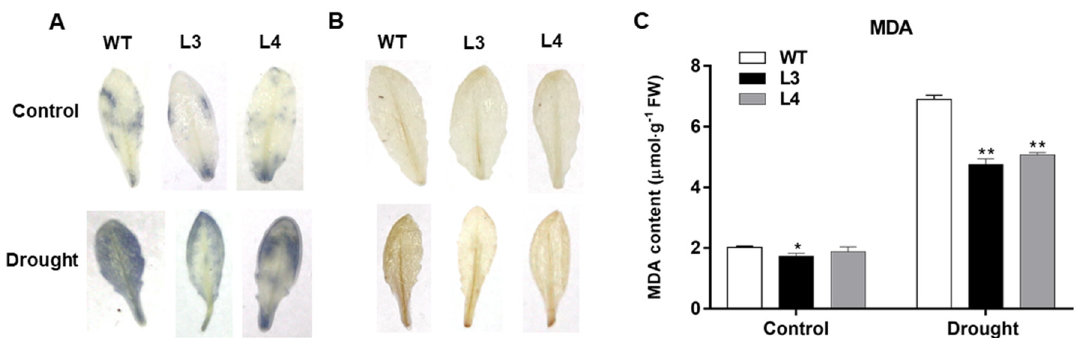
Figure 7. Overexpression of EjWRKY17 decreased ROS production and oxidative damage under drought stress. ( A ) NBT staining, ( B ) DAB staining, ( C ) MDA content. Error bars represent ± SD ( n = 3). Asterisks denote significant differences (as compared with the control group): * p < 0.05; ** p < 0.01.